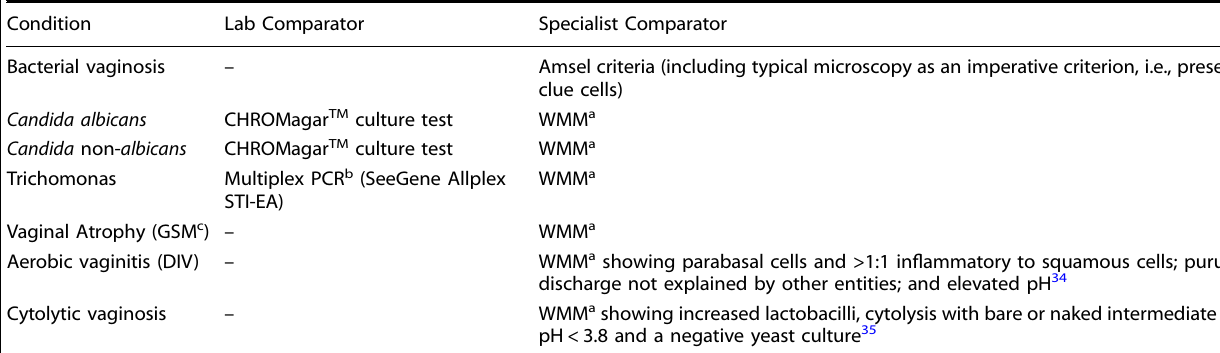
Table 3. Composite reference standard (CRS)